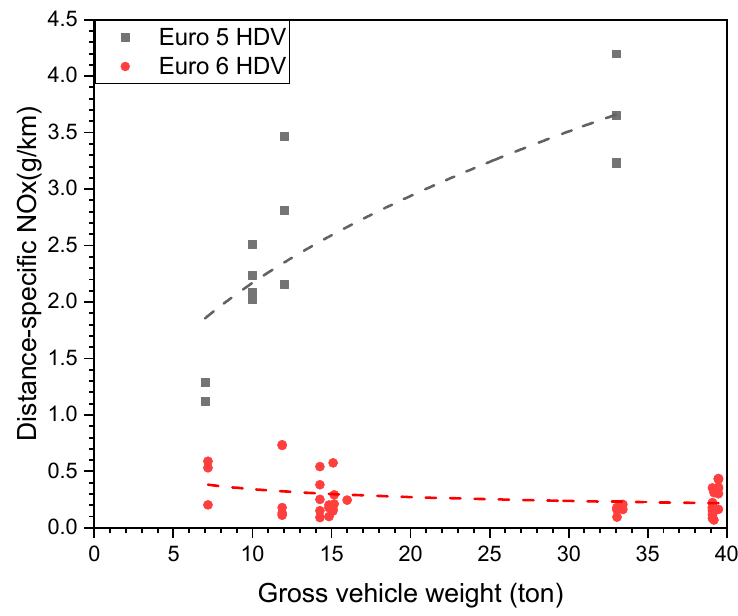
Figure 4. On-road NOx emissions from Euro 5 and Euro 6 heavy-duty diesel vehicles (HDVs) as a function of GVW.